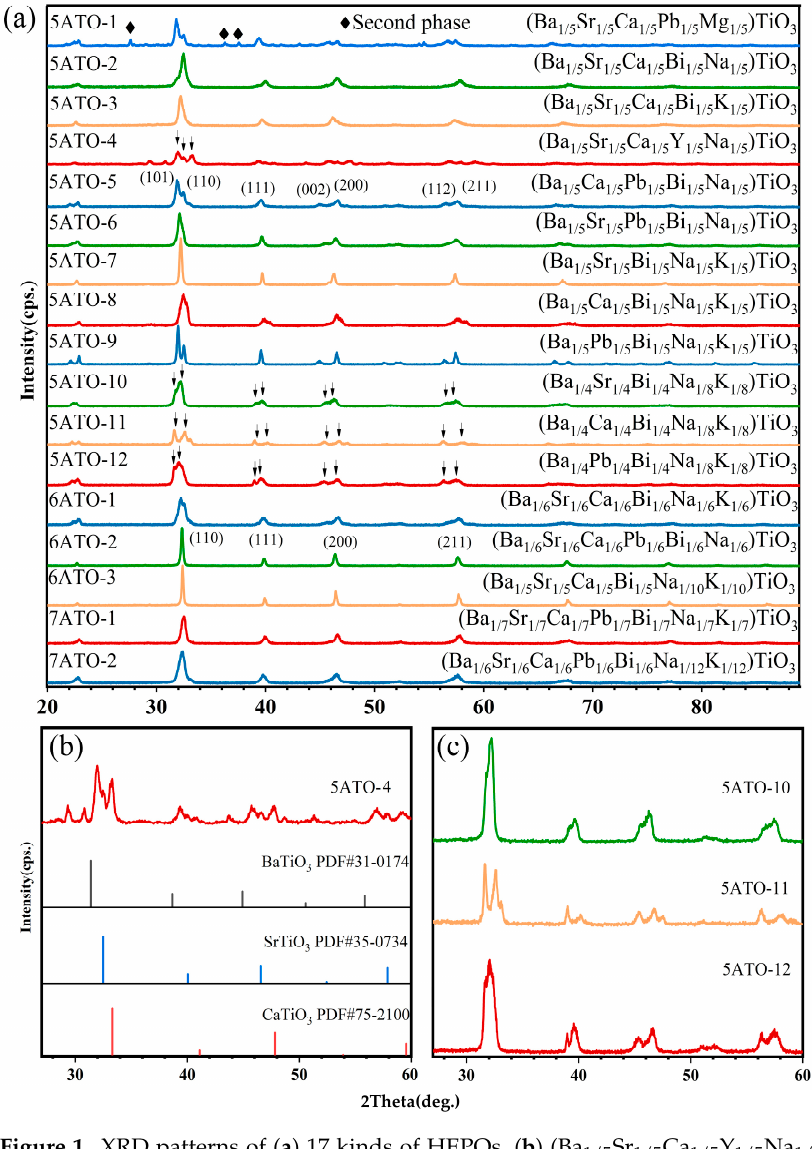
Figure 1. XRD patterns of ( a ) 17 kinds of HEPOs, ( b ) (Ba 1/5 Sr 1/5 Ca 1/5 Y 1/5 Na 1/5 )TiO 3 (5ATO-4), ( c ) (Ba 1/4 Sr 1/4 Bi 1/4 Na 1/8 K 1/8 )TiO 3 (5ATO-10), (Ba 1/4 Ca 1/4 Bi 1/4 Na 1/8 K 1/8 )TiO 3 (5ATO-11), and (Ba 1/4 Pb 1/4 Bi 1/4 Na 1/8 K 1/8 )TiO 3